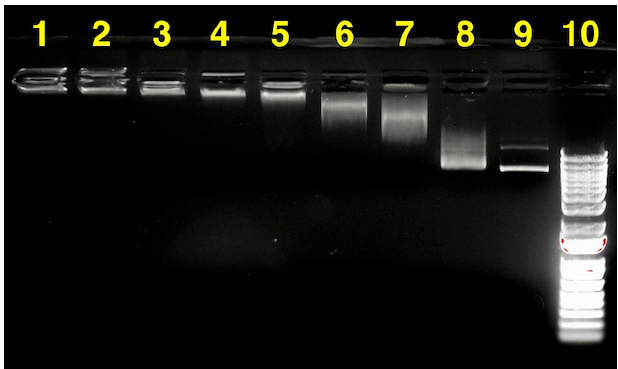
Figure 9. Agarose gel electrophoresis of polymer:pDNA nanocomplexes. Lane assignments are as